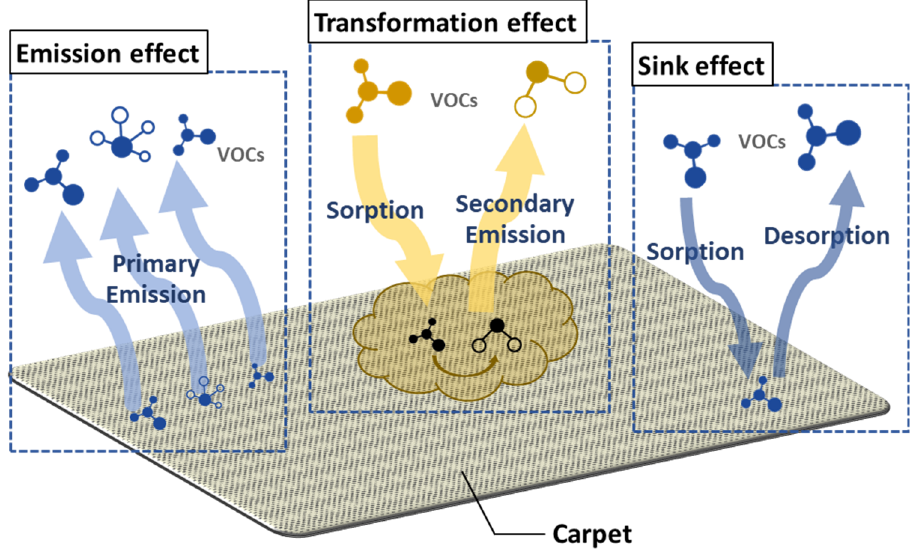
Figure 3. Impact of the carpets on the VOCs concentration in indoor air.